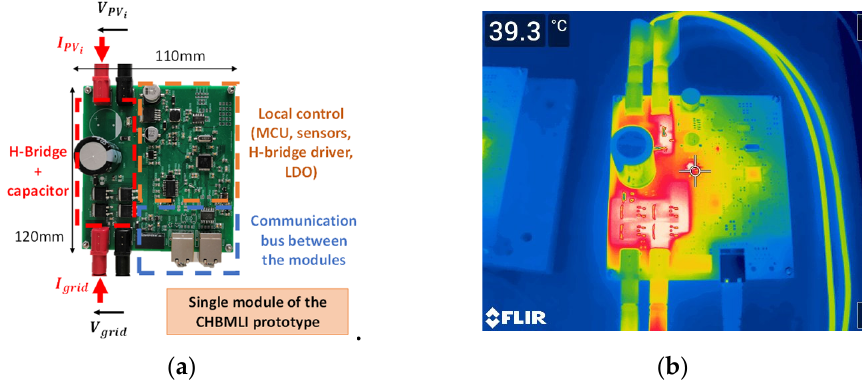
Figure 9. ( a ) Prototype of a single module of the Cascaded H-Bridge Multilevel Inverter (CHBMLI) ( b ) Thermal image of a module at P out = 365 W.